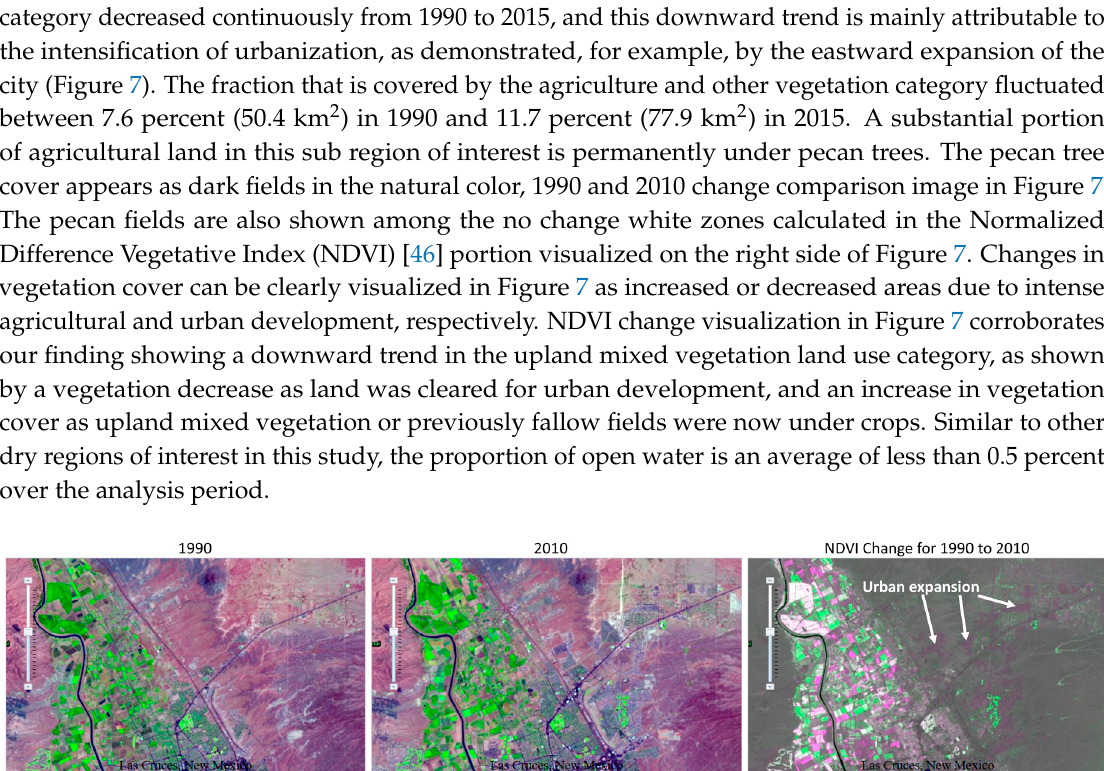
Figure 6. Land use change around the City of Las Cruces, 1990–2015.